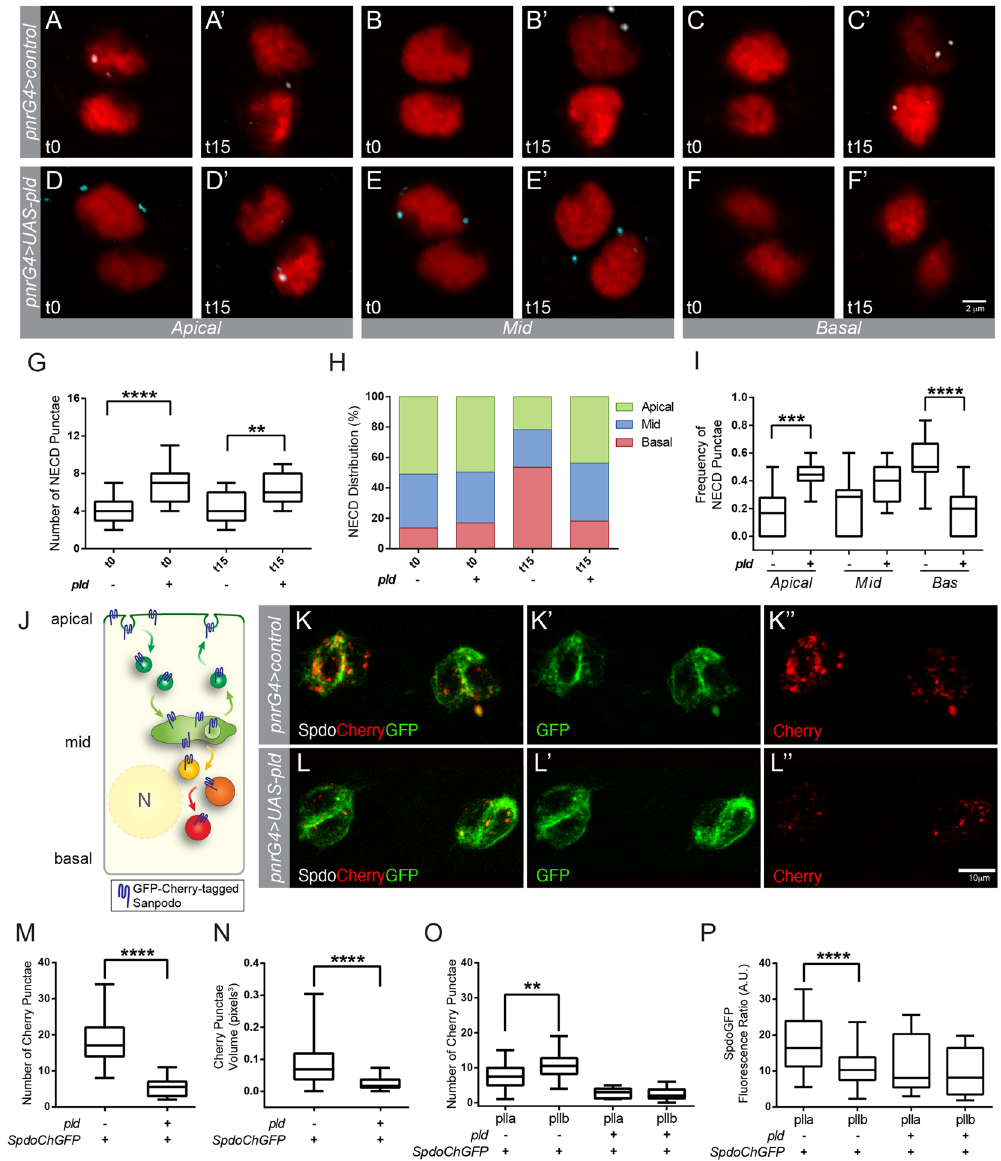
Figure 4. PLD-PA increases endocytosis of Notch receptor and decreases Spdo sorting towards late endosomes. ( A – I ) Pulse and chase in apical, middle, and basal planes using anti-NECD (cyan) to mark the Notch receptor and anti-senseless (red) to identify the SOP cells. ( A – F ′ ) Confocal projections of pIIa (upper) and pIIb (bottom) in 16 hAPF pupae, in control conditions ( A – C ′ ), and overexpression of PLD ( D – F ′ ). Note that in the mid and basal planes there are no NECD+ punctae at t0 but they appear at t15. In contrast, in a PLD overexpression background, NECD is present in the mid plane in both t0 and t15 but there is no signal in the basal plane. ( G ) Quantification of the total NECD+ punctae. ( H ) Spatial distribution of NECD + punctae across the cell. ( I ) Quantification of NECD positive dots frequency at t15. ( J – O ) In vivo imaging of Sanpodo double-labeled with Cherry/GFP during asymmetric SOP division. ( J ) Schematic representation of SpdoCherryGFP distribution along the apico-basal axis. GFP fluorescence (green) is detected at the membrane, early and recycling endosomes. Conversely, Cherry fluorescence (red) is detected in late endosomes and lysosomes. This difference in the punctae fluorescent signal is due to late endosomes and lysosomes have an acidic pH that turns off GFP fluorescence, while the Cherry molecule has a slower maturation time than GFP, so it is not initially detected during endocytosis and protein recycling 47 . ( K – K ″ ) Spdo in vivo imaging in pIIa (left) and pIIb (right) in pupa control. ( L – L ″ ) Spdo in vivo imaging in pupae with overexpression of PLD. ( M ) Quantification of the total Cherry positive dots. ( N ) Volume quantification of Cherry dots. ( O ) Quantification of Cherry positive dots in plla and pllb. ( P ) Quantification of GFP fluorescence in plla and pllb. (( D – F ′ ; t0 n = 16, t15 n = 11 A – C ′ ; t0 n = 26, t15 n = 13; K – L ″ n = 20 ** p < 0.01, p *** < 0.001, **** p < 0.0001). The scale represents 2 µm ( A – F ′ ) and 10 µm ( K – L ″